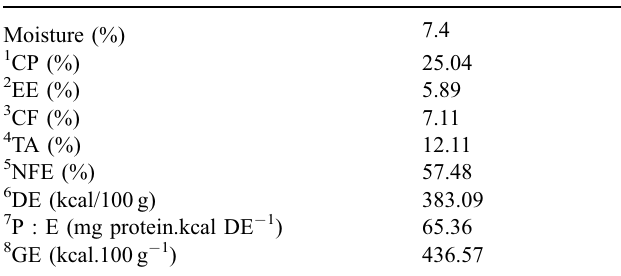
Table 3. Proximate composition of commercial feeds used for C. carpio .